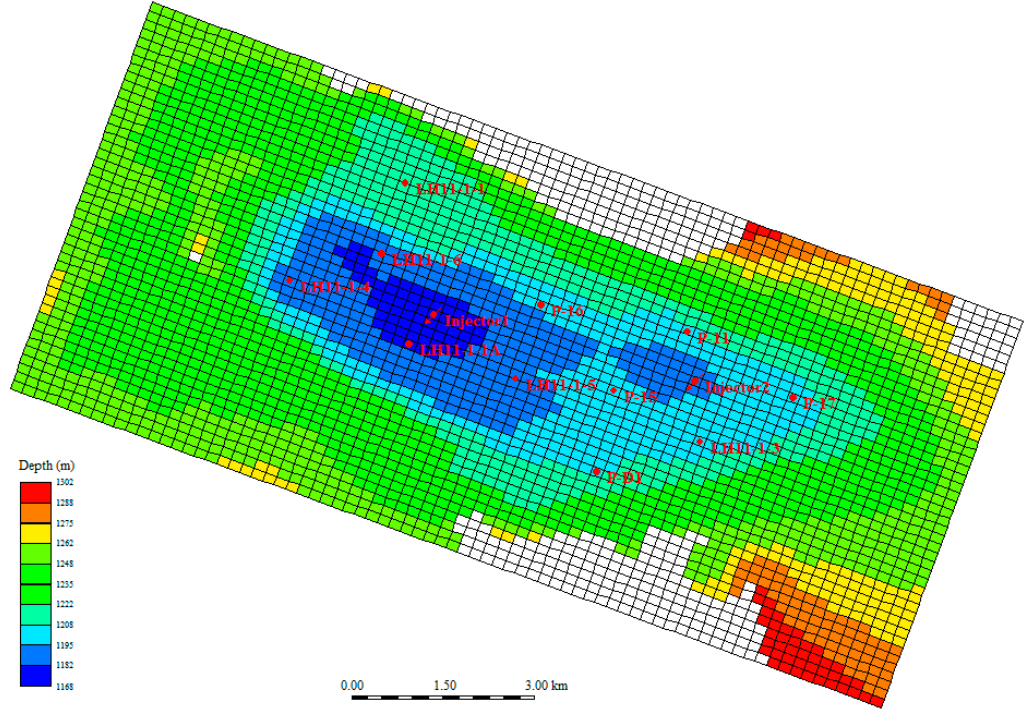
Figure 5. The upscaled grid model of the top reservoir depth structure, which include 3420 grids with NX = 76 grids and NY = 45 grids. The locations of 11 oil production wells and 2 CO 2 injector wells for simulation are also shown. Expect initial 6 oil production wells (including LH11-1–1, LH11-1–1A, LH11-1–3, LH11-1–4, LH11-1–5 and LH11-1–6), 2 injection wells (Injector1 and